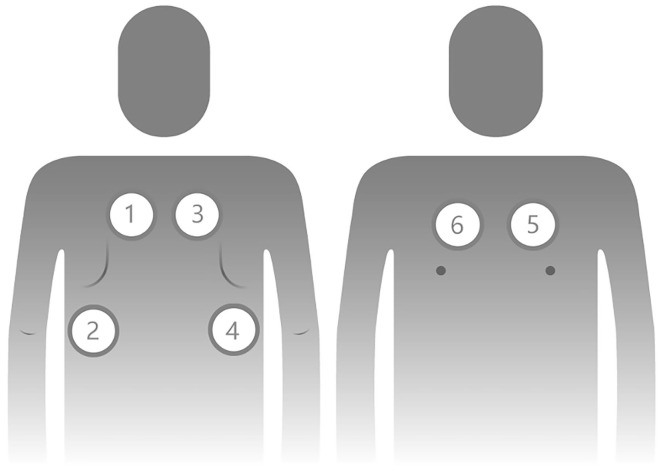
Order and localization of lung auscultation points for pediatric patients. Points 1 to 4 are on the posterior side of the chest, and points 5 and 6 are on the anterior side of the chest.